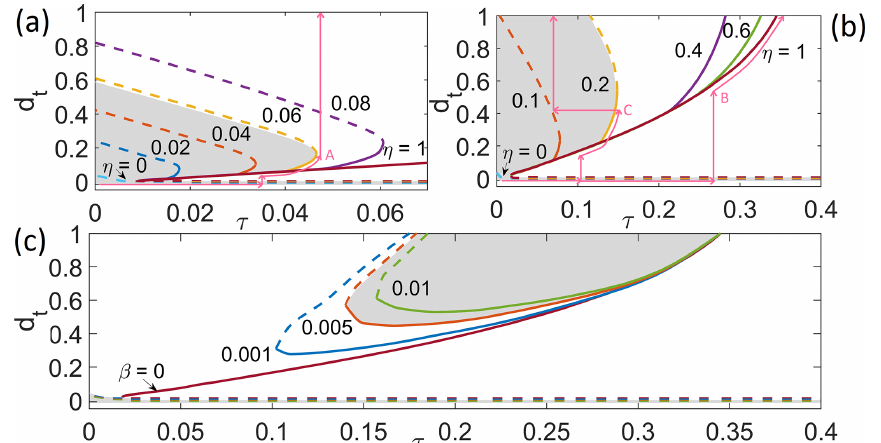
Figure 6. Bifurcation diagram with contact condition, for an ice shelf with a single crack at the top. Each heavy solid or dashed curve is the locus of points satisfying K 1 (d t ; τ,η) = κ or K 1 (d ; τ,β) = κ) in the (τ,d t ) plane at a fixed value of η or β as indicated, representing the boundary of a region of steady states in which K 1 ≤ κ . A solid portion of the boundary curve indicates a stable boundary, and dashed indicates unstable. (a, b) The case of constant η , the value of η being indicated for each curve. The region of steady states generally lies to the left of each curve, as indicated by grey shading for η = 0 . 06 (panel a ) and η = 0 . 2 (panel b ). The two panels differ in the range of τ and η . Note that there is a narrow region of steady states near d t = 0 in each panel (elevated slightly above the bottom of the plot for visibility). Also shown as narrow pink curves are three phase paths that the point (τ,d t ) can follow under changes in τ and η . All paths begin at a small d t and τ = 0; paths A and B correspond to monotonic increases in τ at different fixed values of η = 0.06 (A) and 1 (B). Path C corresponds to a monotonic increase and subsequent decrease in τ at η = 0 . 2 followed by τ being held fixed while η is lowered to 0.1. (c) The case of constant β , values as indicated and steady-state region indicated for β = 0 . 005 using the same plotting scheme as panels (a) and (b) . Note that there is again a narrow region of steady states near d t =